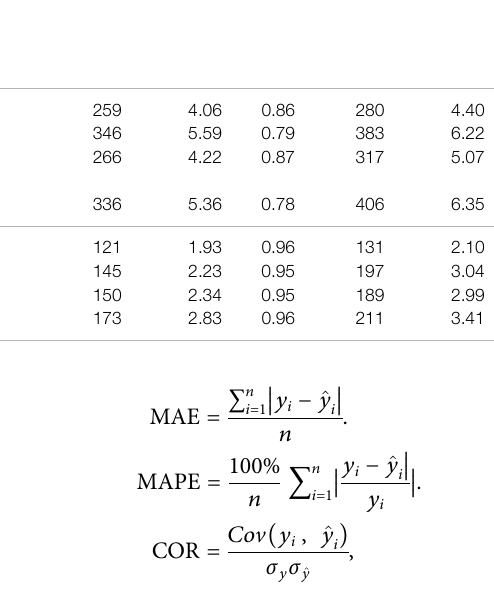
TABLE 1 | Performance evaluations of different models with or without Seasonal – Trend decomposition using Loess (STL). Horizons One-step ahead Two-step ahead Three-step ahead Indices Mean